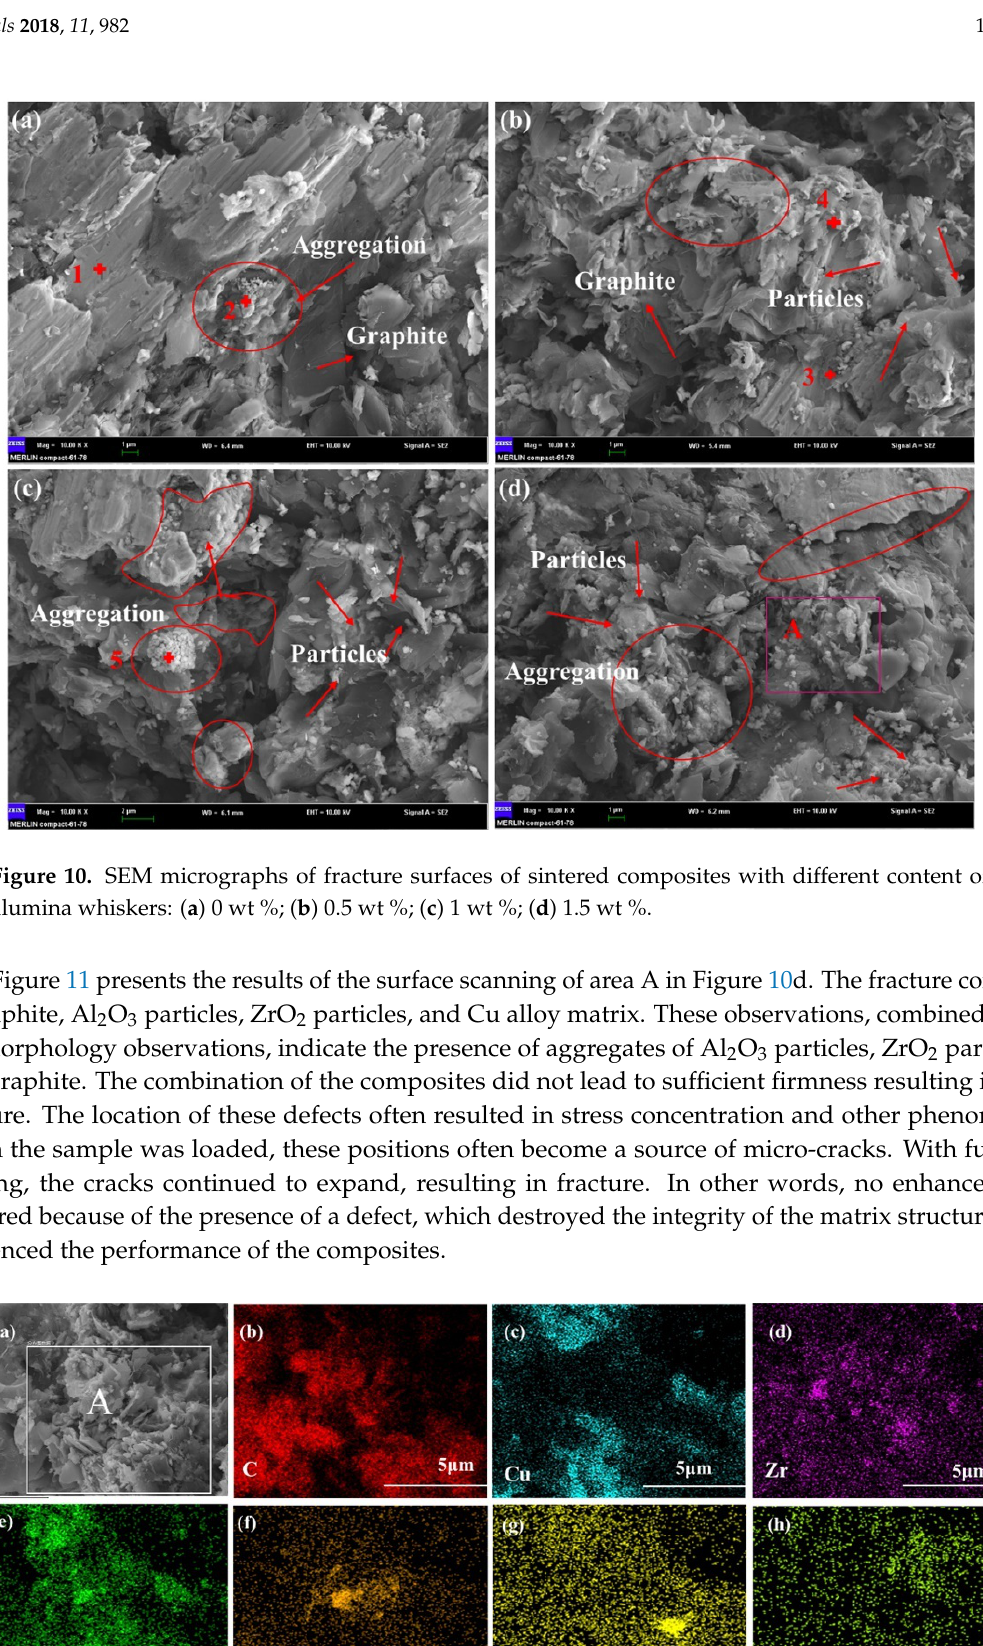
Figure 11. Corresponding EDS elemental mappings of micro-zone A in Figure 10d: ( a ) SEM of zone A; ( b ) C; ( c ) Cu; ( d ) Zr; ( e ) O; ( f ) Al; ( g ) Pb; ( h ) Sn.